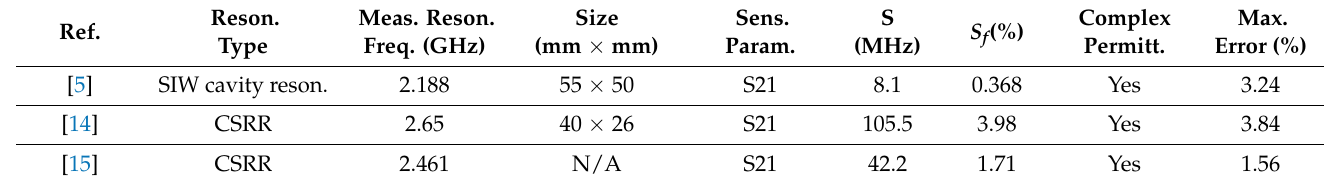
Table 4. Comparison between results of the proposed sensor and other sensors reported in the literature. Reson. Meas. Reson. Ref. Type Freq. (GHz) SIW cavity reson.